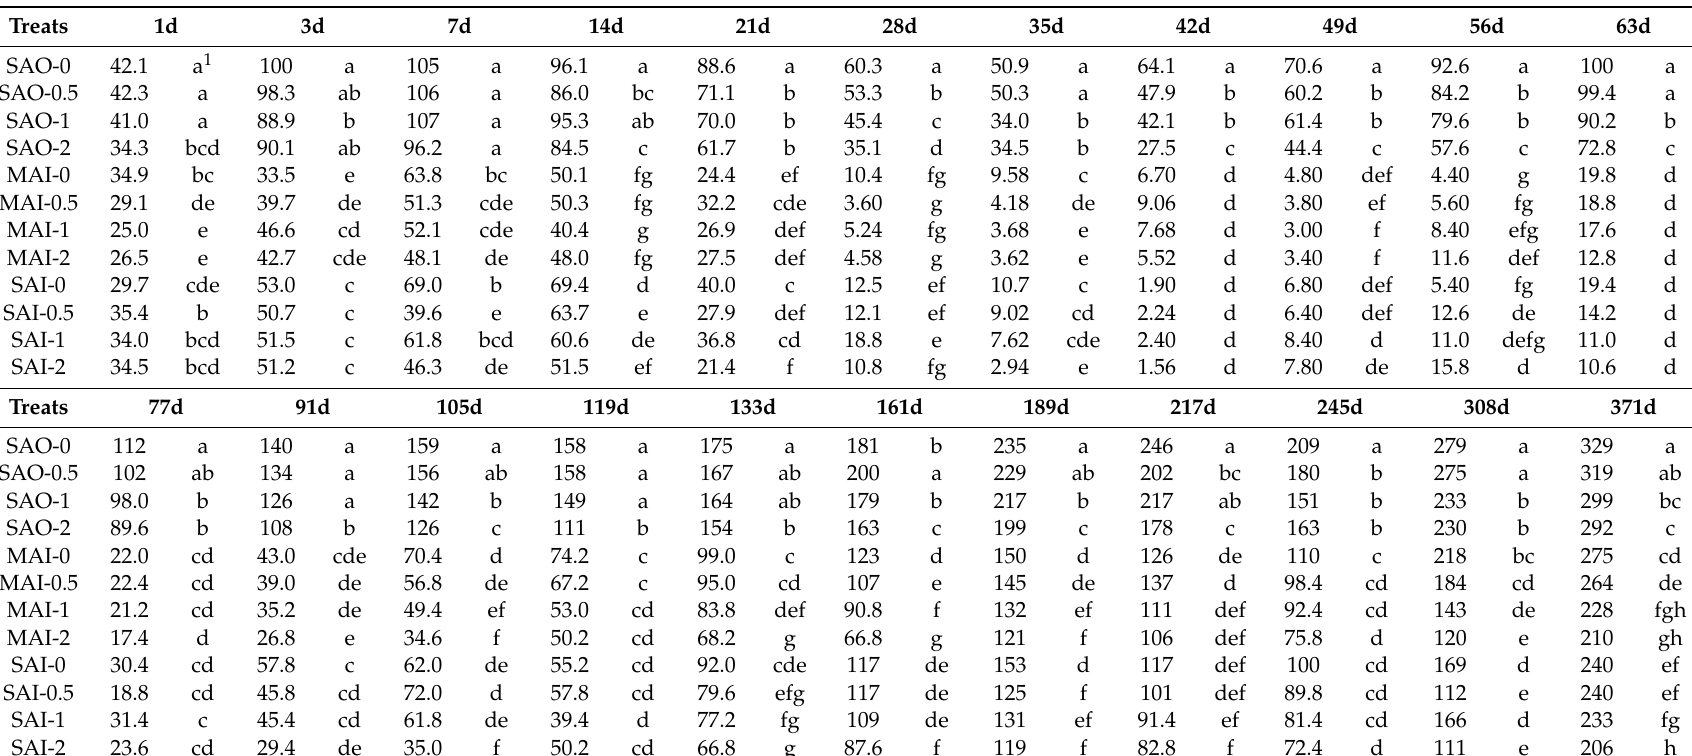
Table 5. Soil inorganic N (NO 3 − -N + NH 4 + -N) levels (mg / kg) in three studied soils during a 371-day incubation 1